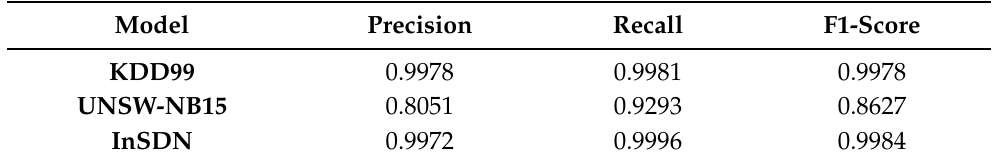
Table 5. TSMASAM performance on other datasets.